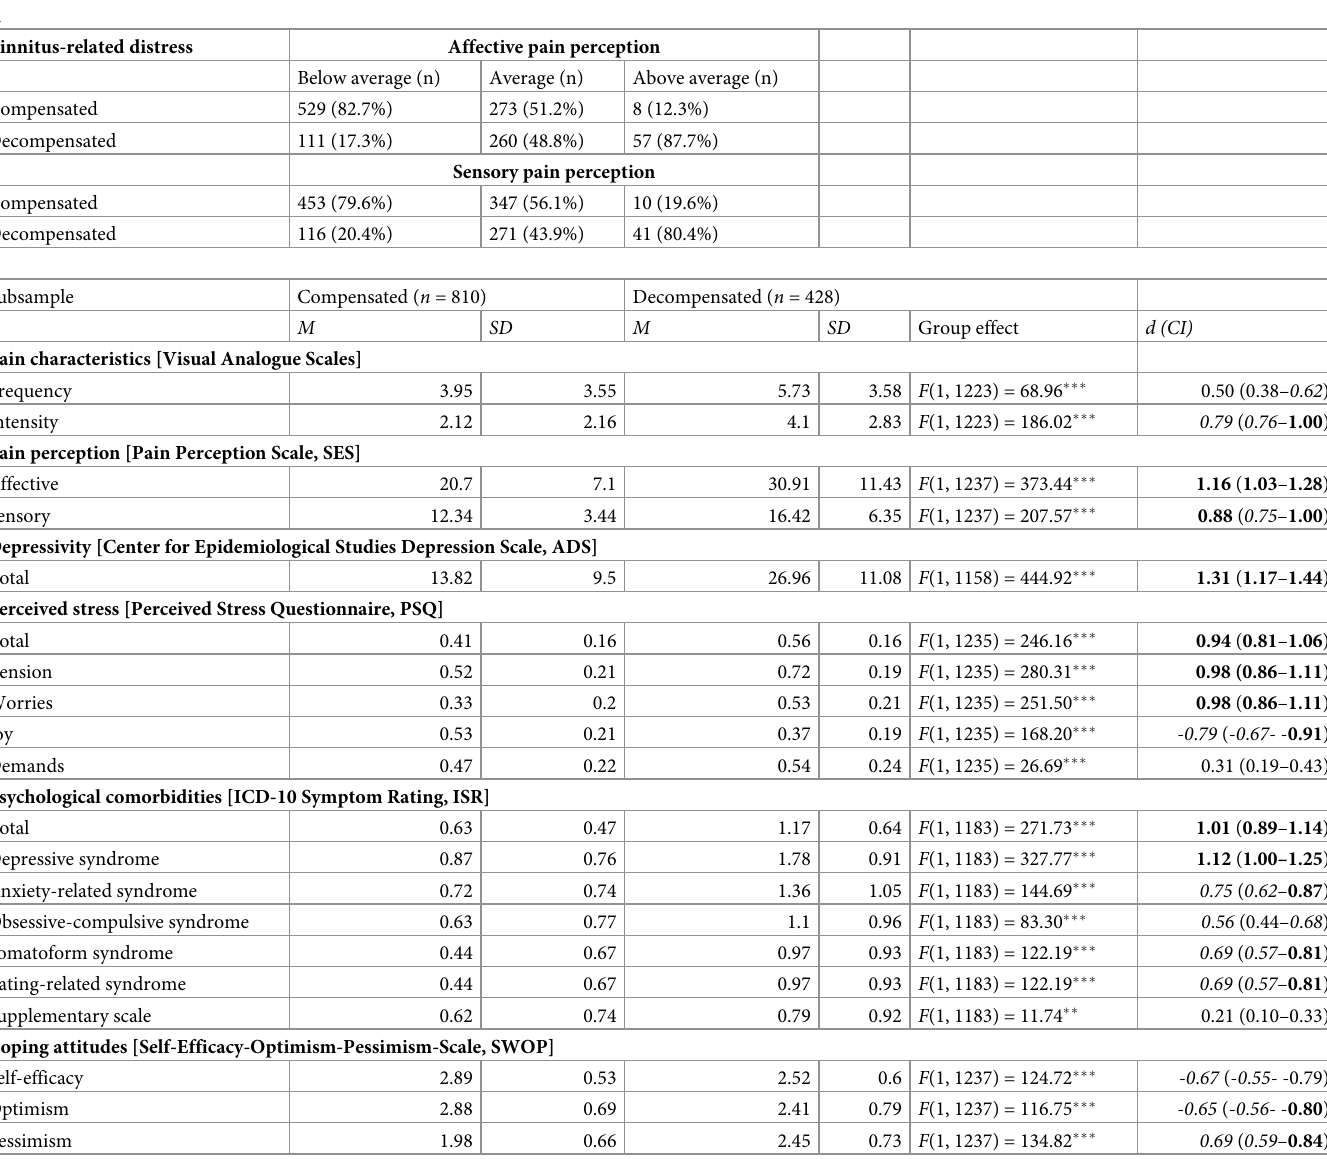
Table 3. Panel a: Frequencies across tinnitus- x pain-related distress categories. Panel b: Means, standard deviations, comparisons of means and effect sizes d for the total, compensated and decompensated patient samples.